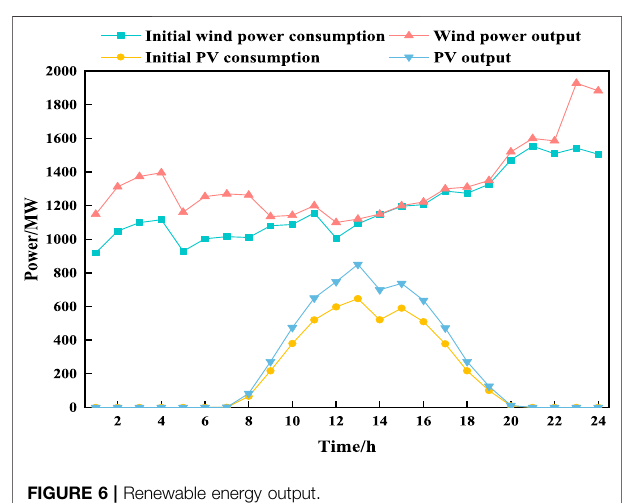
FIGURE 6 | Renewable energy output.